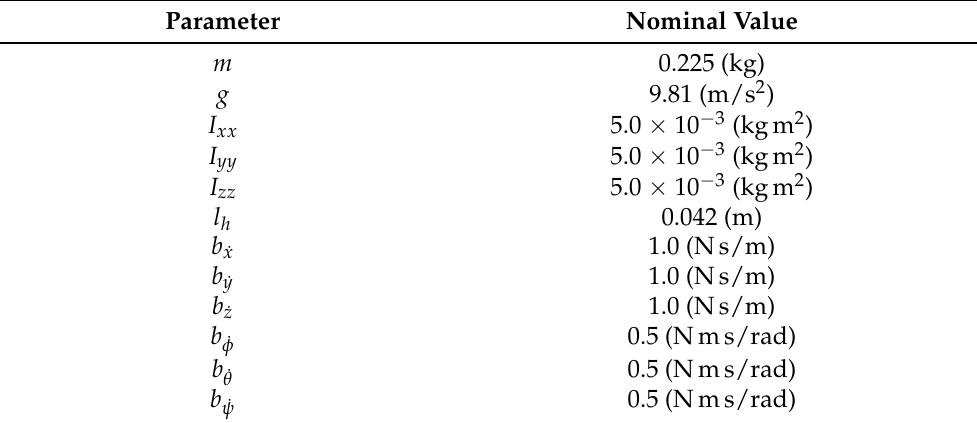
Table 1. Dynamic parameters of the quadrotor.